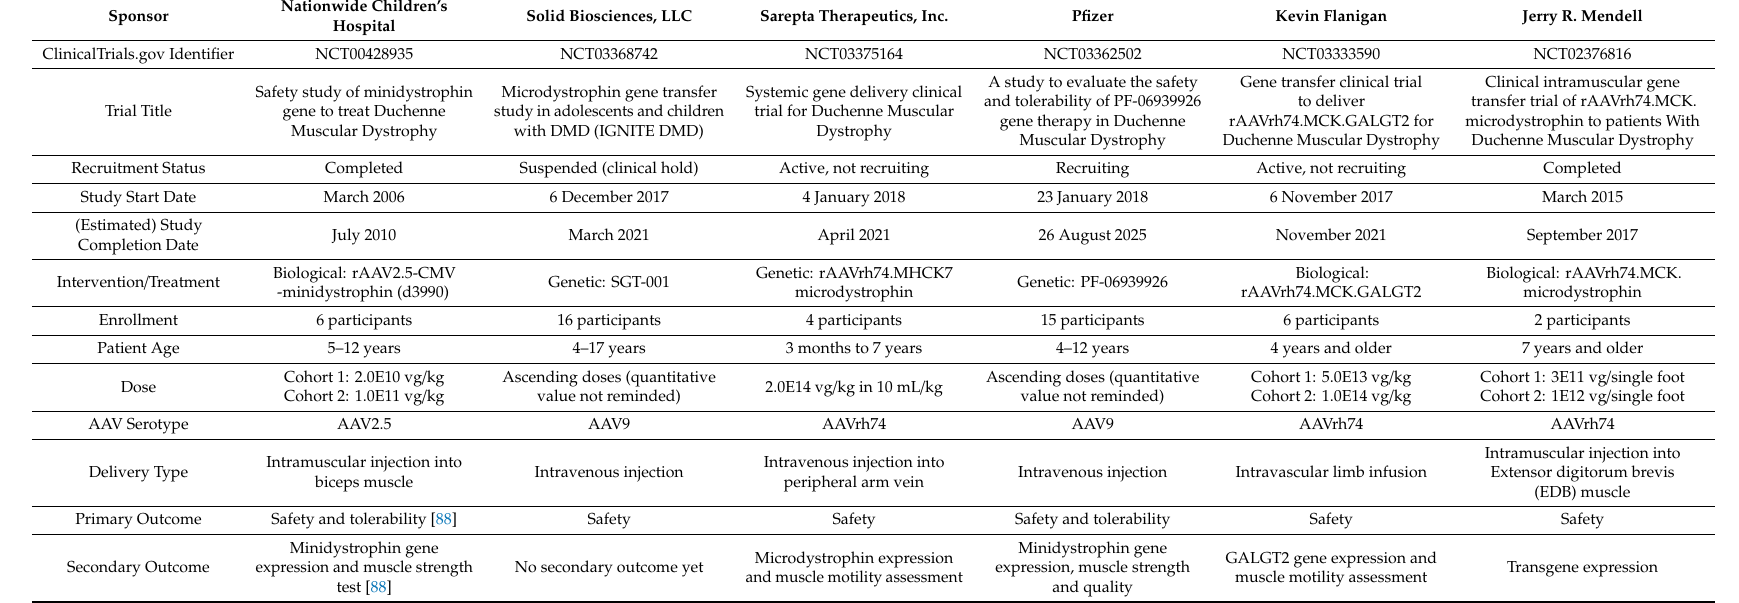
Table 2. Clinical trials of Adeno-associated virus (AAV)-mediated microdystrophin transfer for Duchenne muscular dystrophy (DMD)